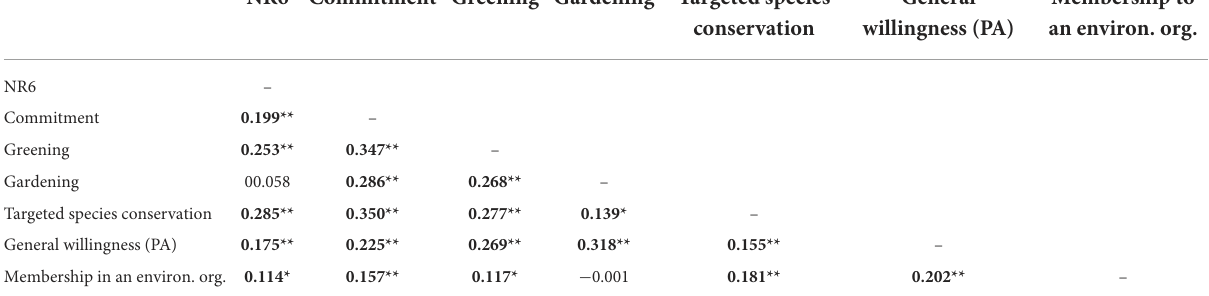
TABLE 3 NR6 and involvement of the